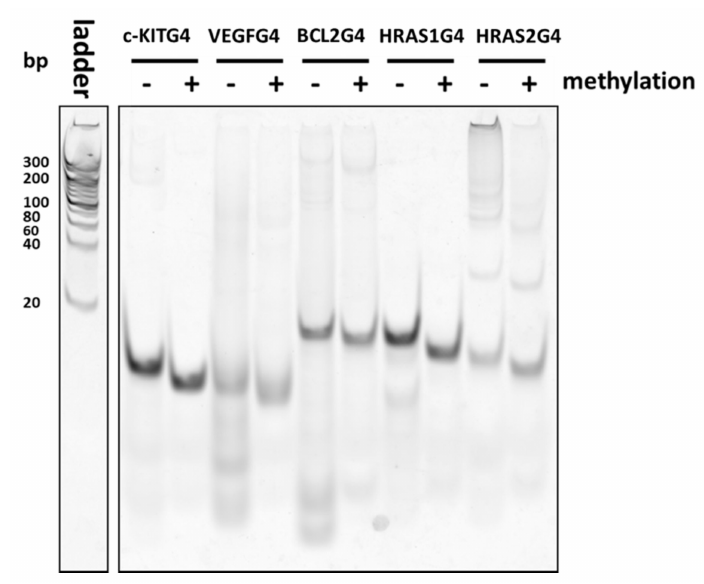
Figure 6. Native-PAGE of the unmethylated and methylated c-KIT , BCL-2 , VEGF , HRAS1 , and HRAS2 G4 DNAs. Oligonucleotides fluorescently labelled with TAMRA were detected. Ladder: DNA